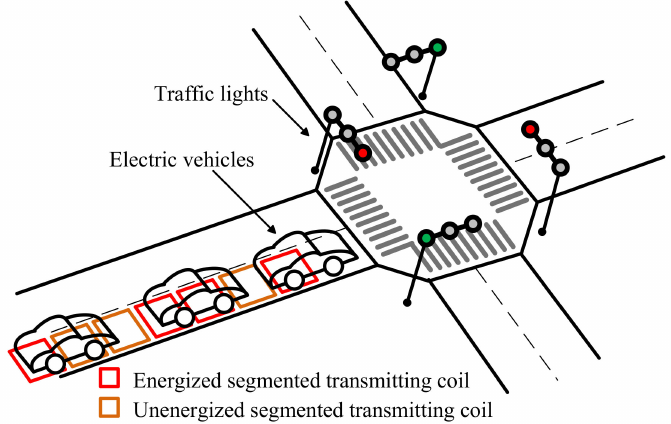
Figure 1. The schematic diagram of the proposed static-dynamic hybrid wireless charging